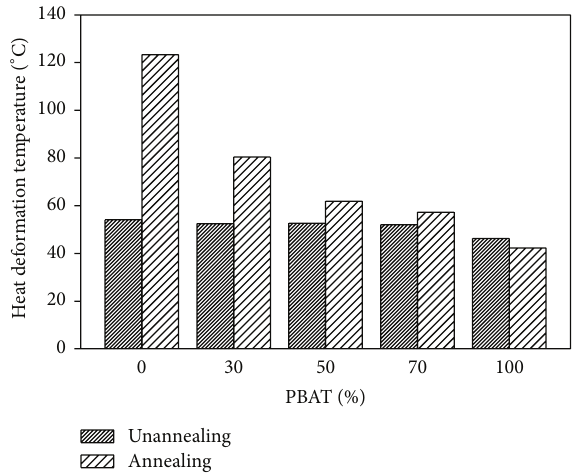
Figure 10: Relationship between heat deformation temperature and composition of the PLA/PBAT.